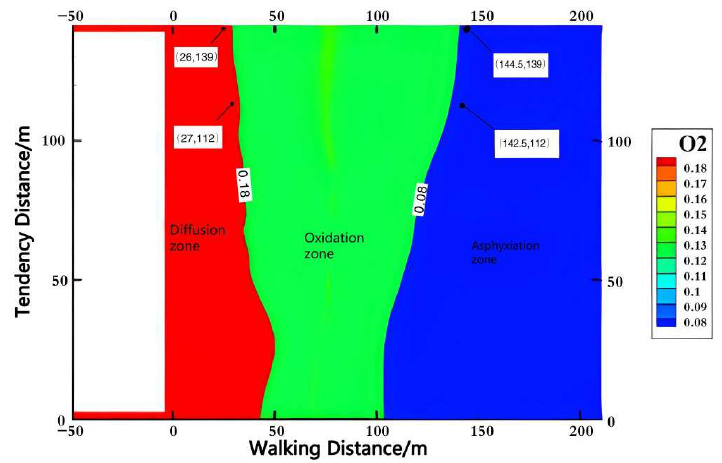
Figure 10. Comparison of beam tube data and numerical simulation.